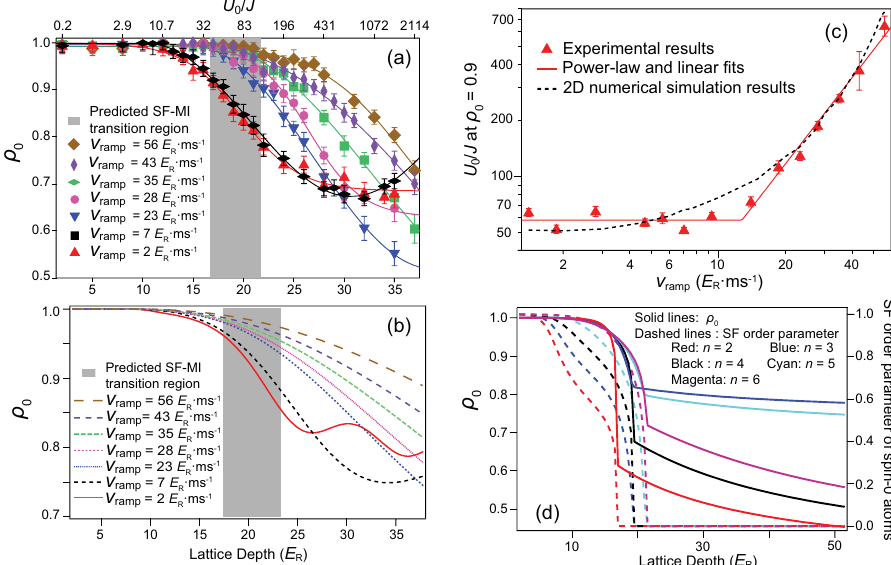
Fig. 2 Quantum critical dynamics probed via spin populations. a Observed spin dynamics at various lattice quench speeds v ramp in magnetic fi elds of q / h = 42 Hz. Here, q is the quadratic Zeeman energy, h is the Planck constant, the unit of v E R per millisecond ( E R ⋅ ms − 1 ), E R is the recoil energy, and ramp is ρ fi gure is the fractional population of the spin-0 component. Solid lines are fi tting curves to guide the eye (see “ Methods ” ), and the shaded gray 0 in the area represents the predicted super fl uid to Mott insulator (SF-MI) transition region for the fi lling factors n of 1 ≤ n ≤ 6. The top horizontal axis lists the corresponding U 0 / J , where U 0 is the spin-independent interaction energy and J is the hopping energy. b Similar to panel a but derived from the Bose – Hubbard model for 2D lattice-trapped sodium spinor gases (see “ Methods ” ). c Markers correspond to U 0 / J extracted from panel a at the cutoff of ρ = 0.9 as a function of v fi t of the data in fast quenches and a linear fi t in slow quenches. The dashed line is the 0 ramp . The solid line represents a power-law 2D numerical simulation result. d Solid (dashed) lines represent the predicted ρ 0 (the SF order parameter of the spin-0 component) versus the lattice depth u L after adiabatic ramps in 3D lattice-trapped sodium spinor gases at q / h = 42 Hz. Results for a Mott lobe of a certain fi lling factor n are marked in a given color. The SF order parameter is nonzero (zero) in the SF (MI) phase (see “ Methods ” and Supplementary Note 2). Error bars represent one standard deviation.